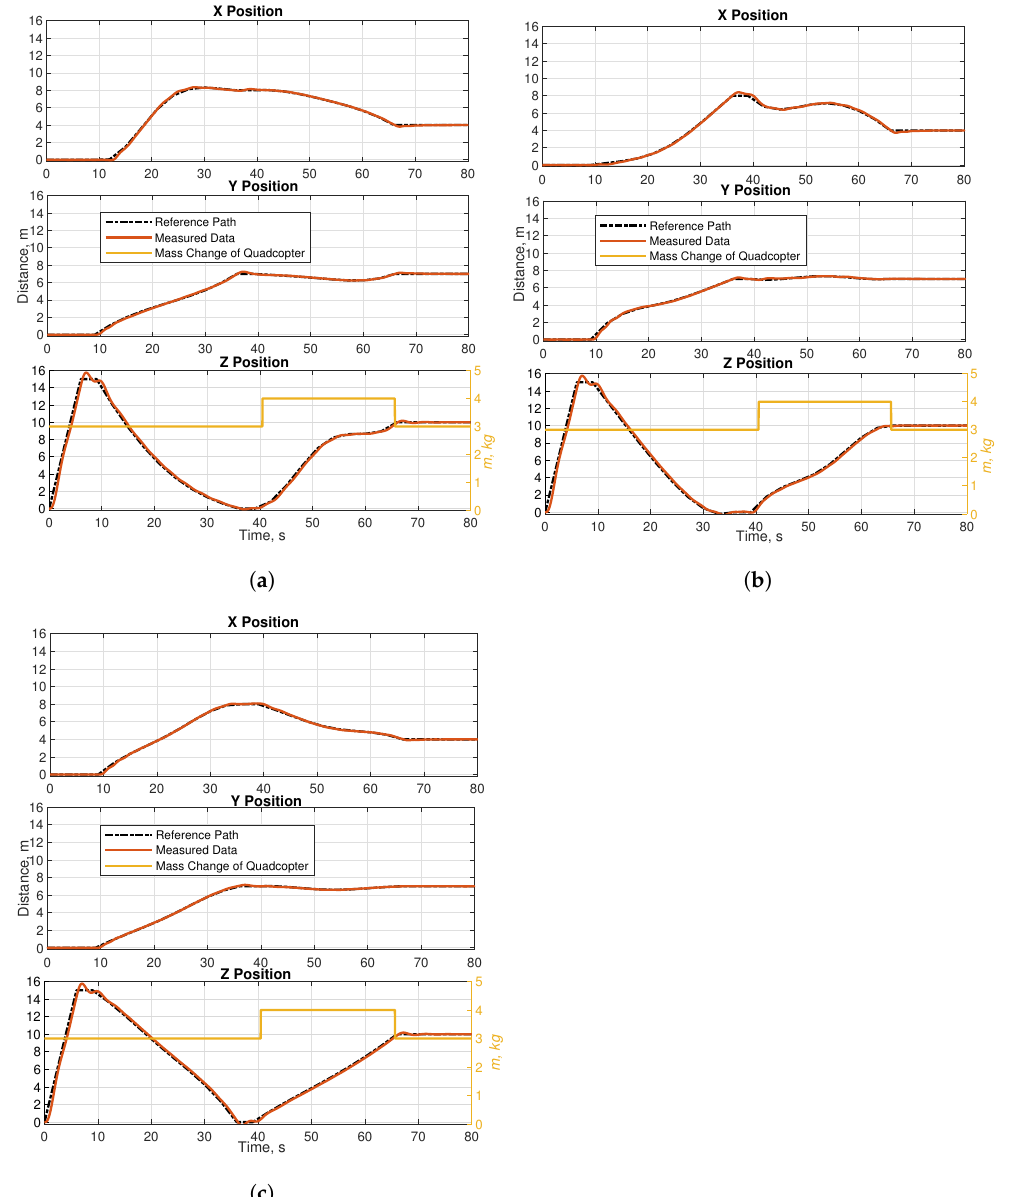
Figure 14. The path-tracking performance of quadcopter for Map 3 ( a ) using PSO, ( b ) using GWO, and ( c ) using hybrid